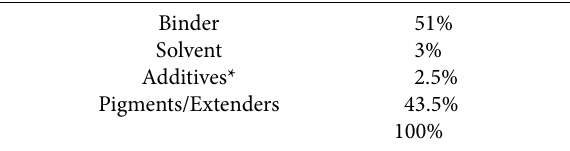
Table 1. Initial composition of the formula